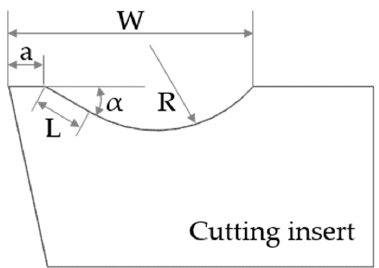
Figure 2. Geometric parameters of the chip breaker: Land width (a), tool-chip contact length (L), rake angle ( α ), radius of curvature ® and groove width (W).